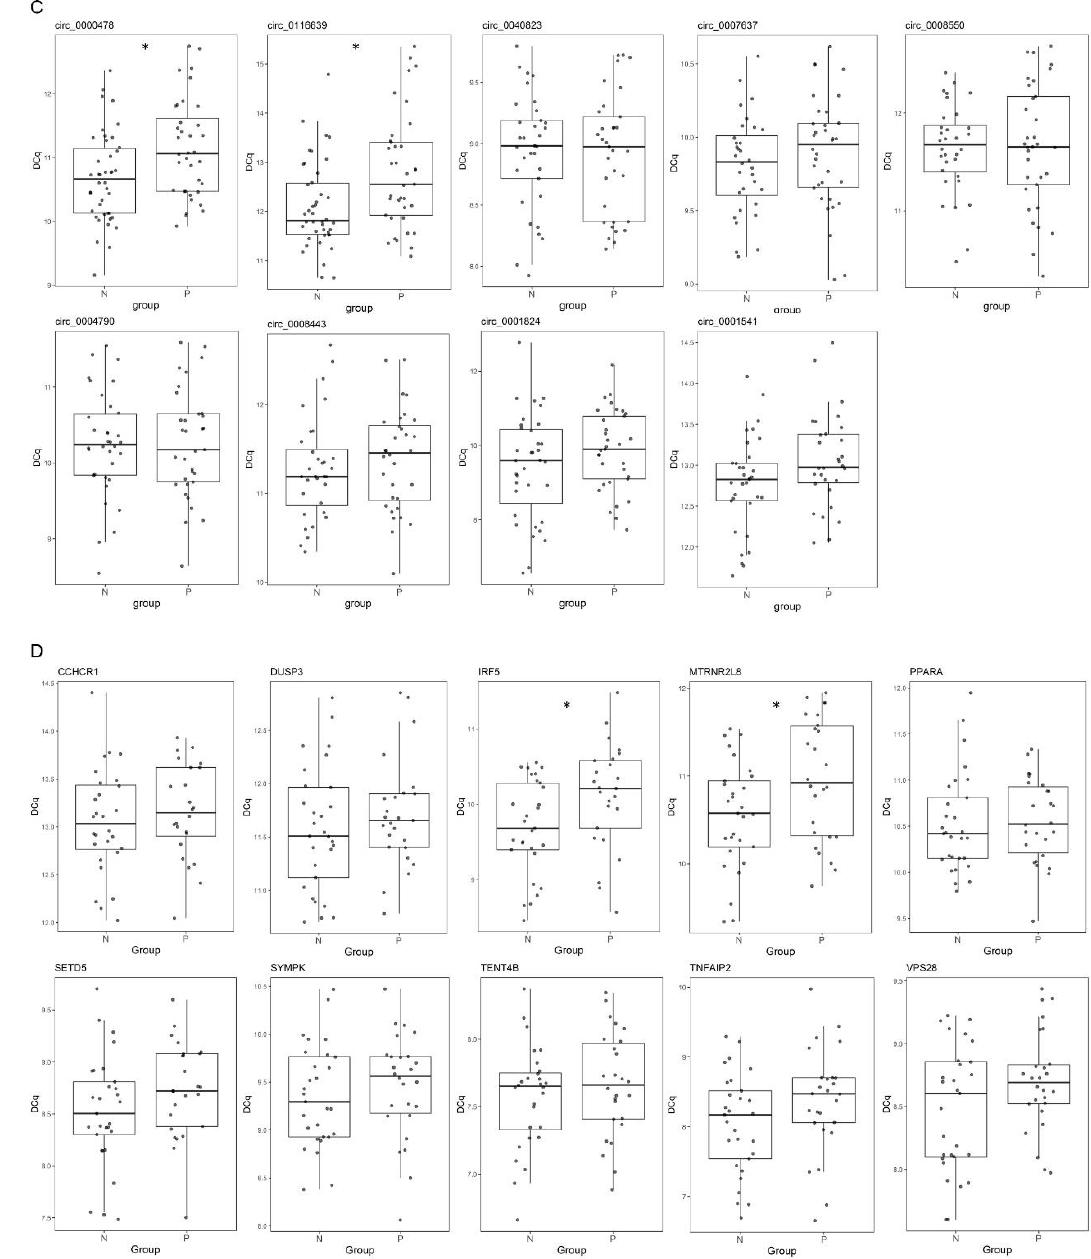
Figure 3. Results of circRNAs and linear RNAs expression profile by RNA-seq. ( A ) Volcano plot showing the expression difference (log2 FC) between positive and negative group of circRNA that show a sum of reads across all samples higher than 10. DEcircRNA are highlighted in red and labels point at those DEcircRNA with a base mean higher than 5. ( B ) Volcano plot showing the expression difference (log2 FC) of linear RNAs between positive and negative groups. Differentially expressed linear RNAs are highlighted in red and labels point at those DE linear RNAs with an adjusted p -value < 0.01. ( C ) RT-qPCR validation results of selected candidate circRNAs. Asterisk indicates a statistically significant difference ( p < 0.01). circ_0000478 and circ_0116639 validation includes more samples than the rest of the circRNAs because of limitations in sample amount (Table S1). ( D ) RT-qPCR validation results of selected candidate linear RNAs. Asterisk indicates a statistically significant difference ( p < 0.05). P: positive LS-OCMB status. N: negative LS-OCMB status.